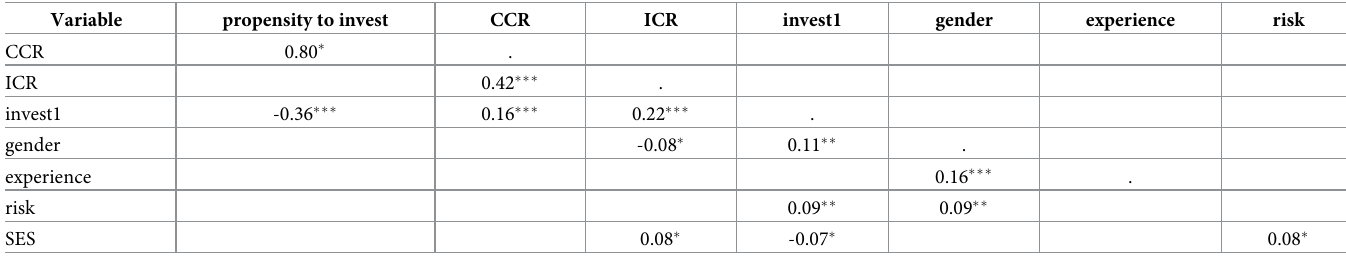
Table 3. Pairwise correlations matrix for the model of propensity to invest. Variable propensity to